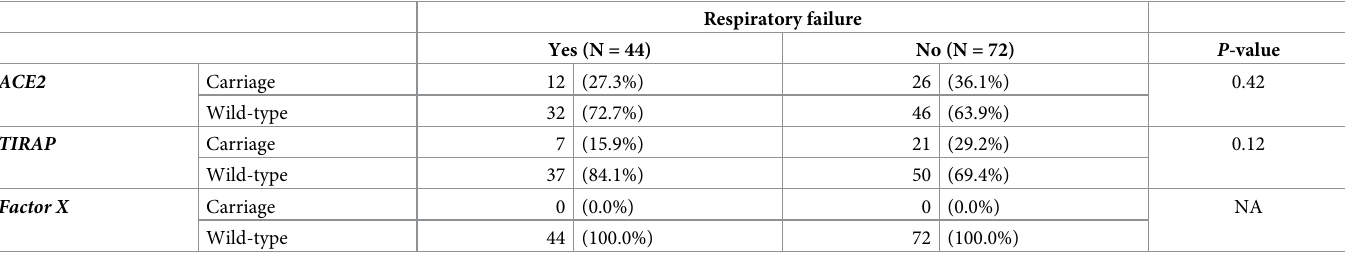
Table 4. Genotype frequencies in patients with and without respiratory